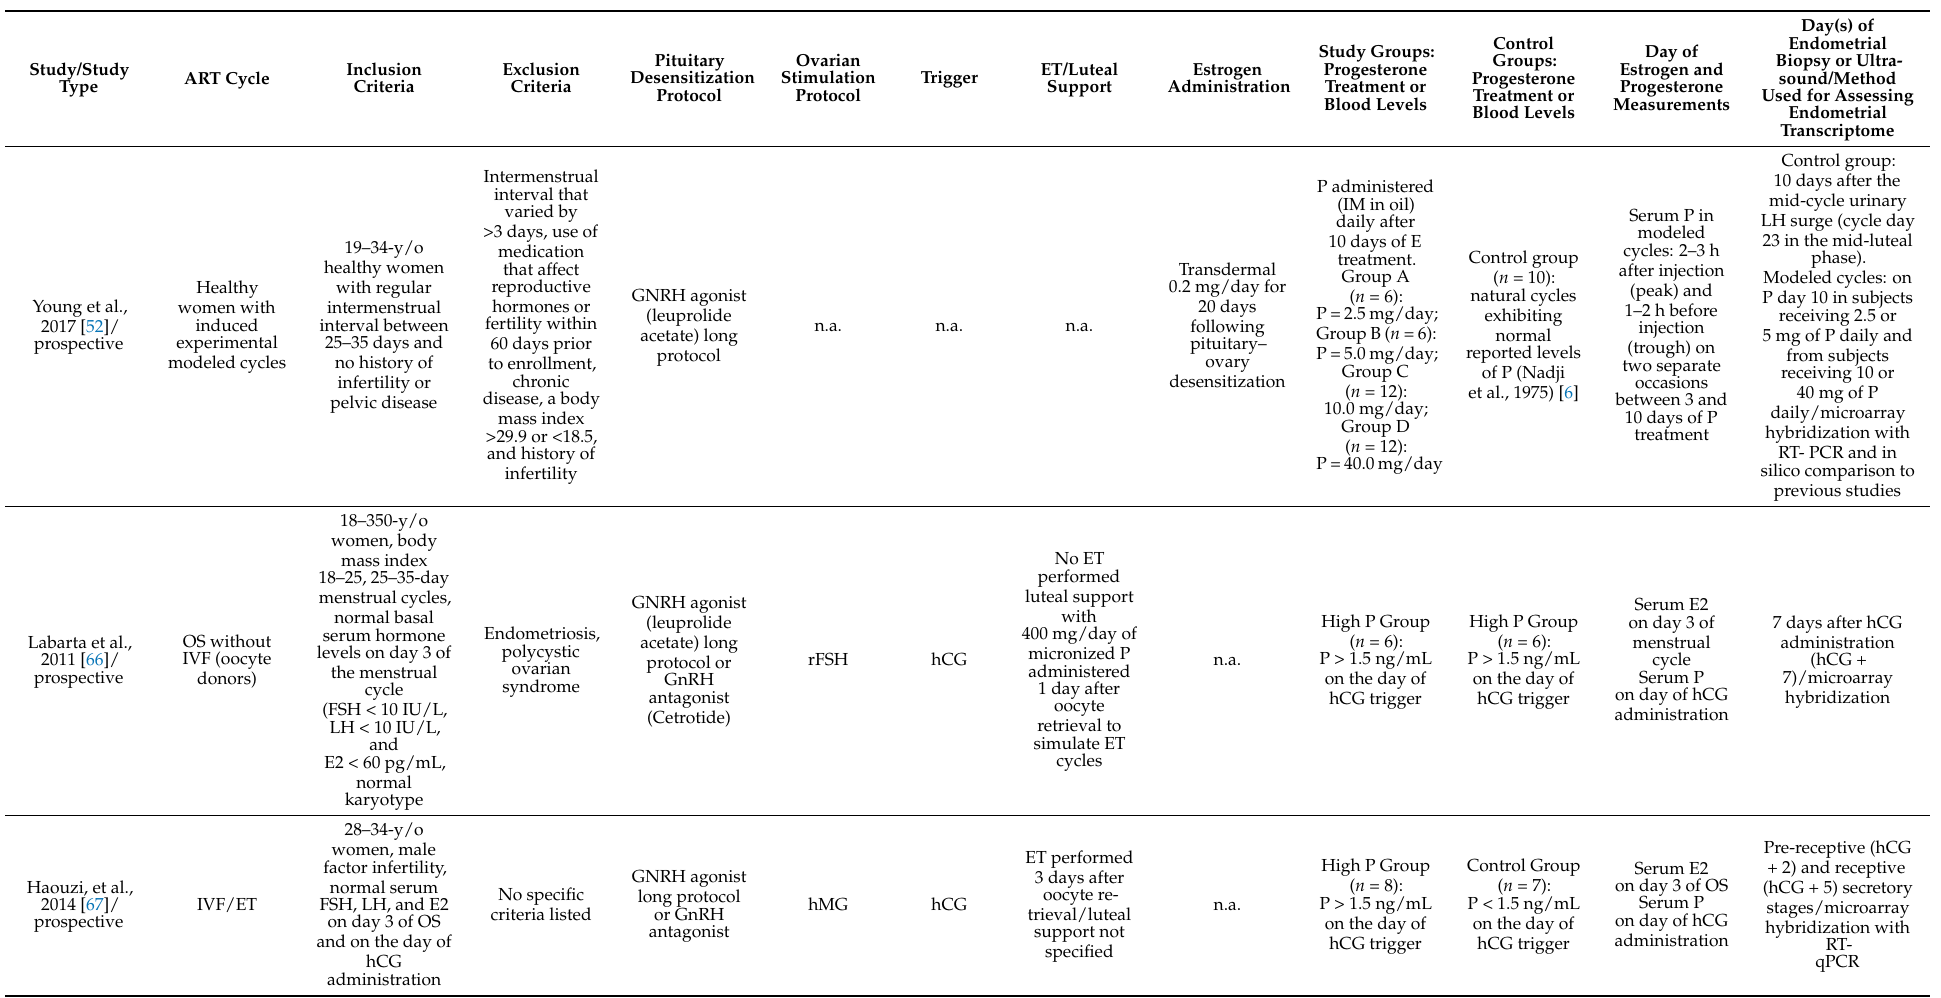
Table 2. Assessing the impact of progesterone levels on the endometrial transcriptome and